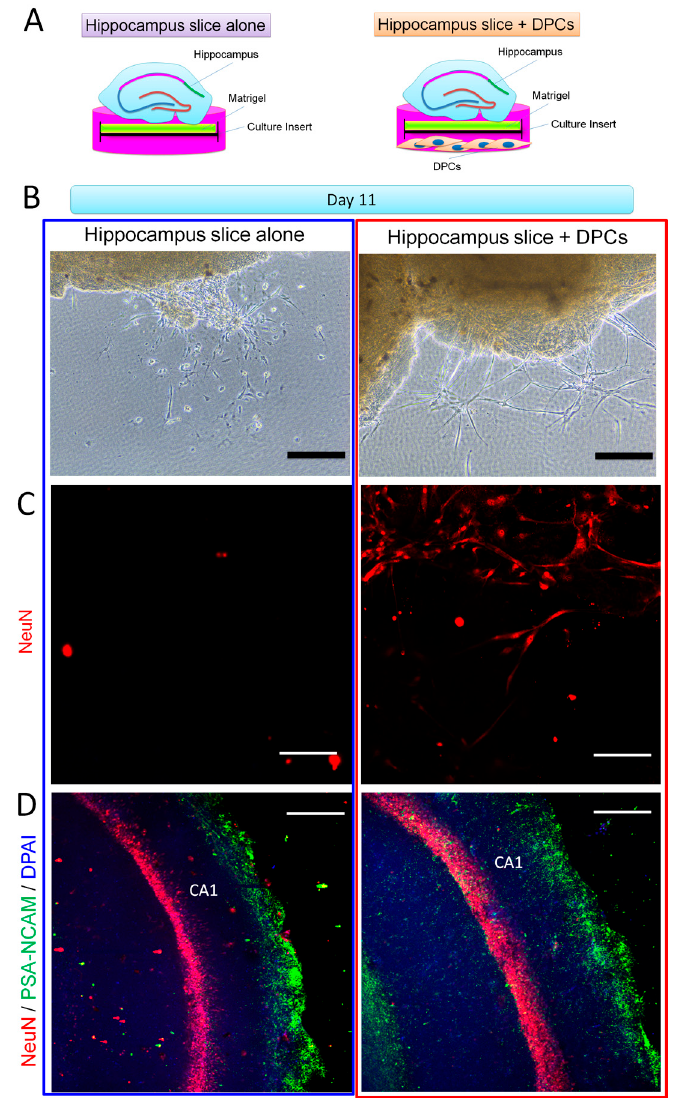
Figure 5. Effect of DPCs on neurogenesis in adult mouse hippocampal slices in vitro. ( A ) Experimental setup. Mouse hippocampus slices were cultivated on matrigel with DPCs or by themselves for 11 days, followed by immunofluorescence staining; ( B ) Images were taken by a phase contrast microscope. Hippocampus slice-derived cells showed glia cell-like morphology when cultivated alone (left). However, when the hippocampus slice co-cultivated with DPCs, the derived cells exhibited neuron-like morphology and formed networks. Scale bar = 50 µ m ( C ) Immunofluorescence staining showed that cells derived from the co-cultivated hippocampus slice are positive to the mature neuron mark NeuN (right). However, cells derived from the single cultivated hippocampus did not react with NeuN (left). Images were taken by LSM. Scale bar = 25 µ m; ( D ) In solo or co-cultivated hippocampus slices, cells reacted with NeuN and PSA-NCAM (a marker of developing and migrating neurons) antibodies. Images were taken by LSM. Scale bar = 50 µm.